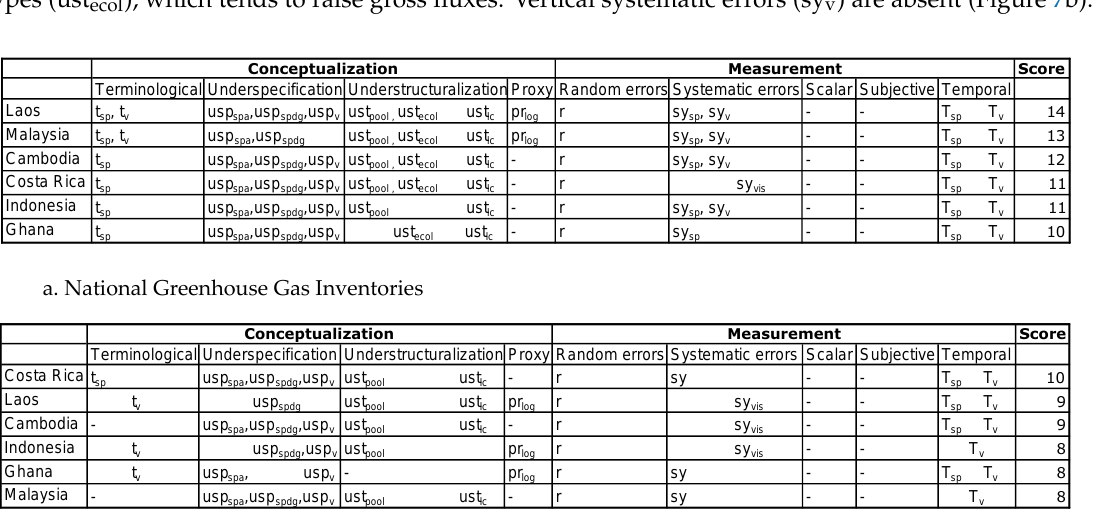
Figure 7. Uncertainty Fingerprints for the comprehensive group of six tropical countries of estimates in ( a ) National Greenhouse Gas Inventories; ( b ) Forest Reference Emission Level reports [55,57 – 61,67,69 – 73].